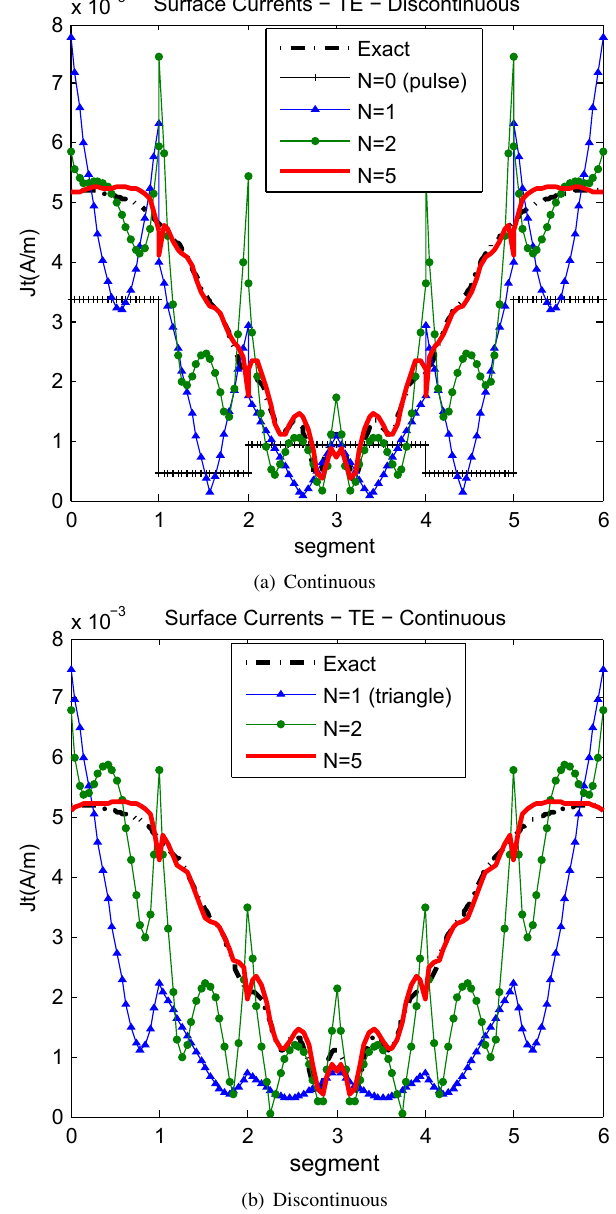
Figure 10: (TE polarization) Surface current estimation with different orders for r = λ , L = λ